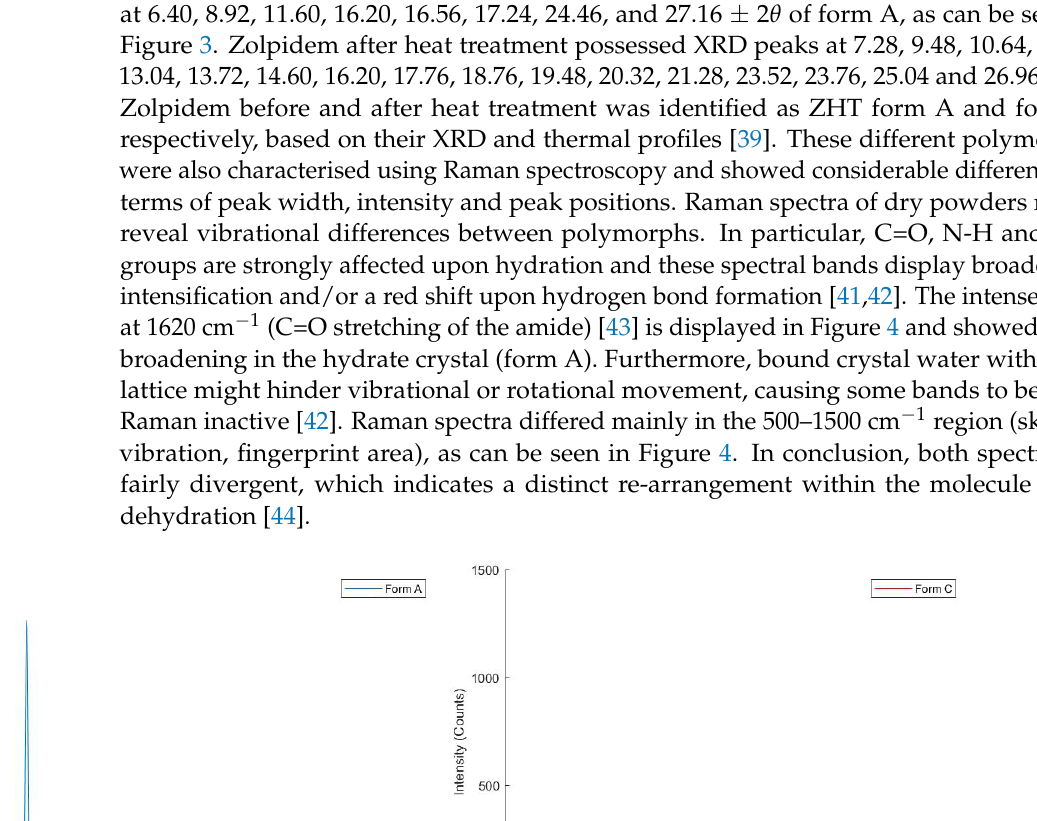
Figure 3. Zolpidem after heat treatment possessed XRD peaks at 7.28, 9.48, 10.64, 12.48,